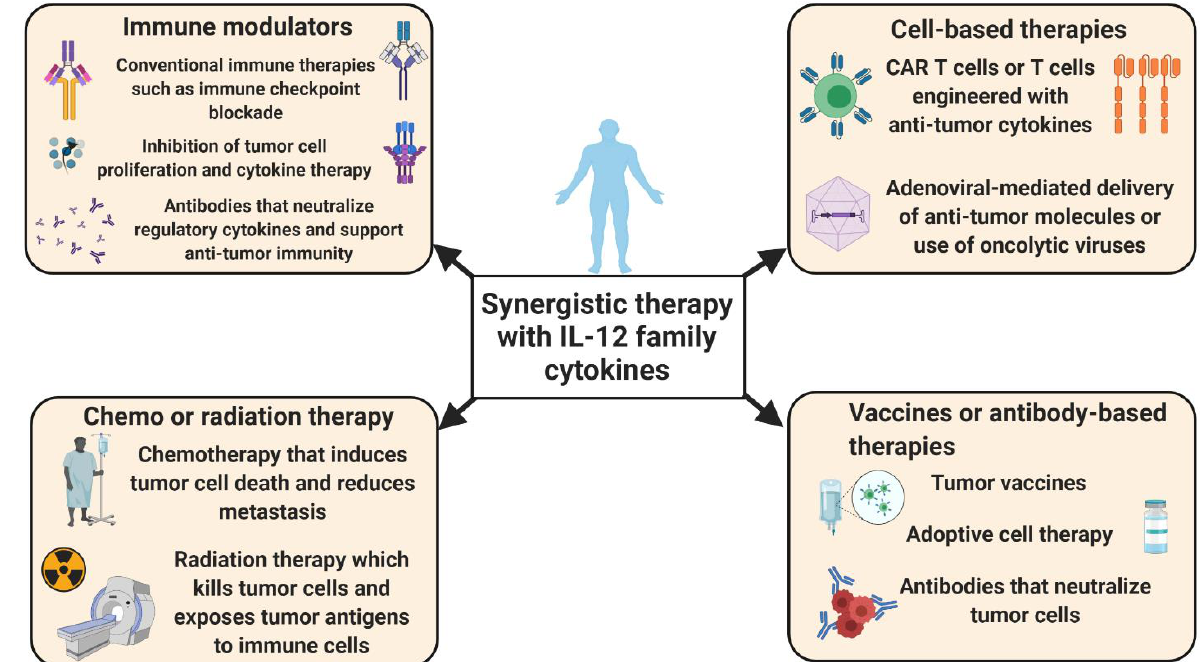
Figure 2. The therapeutic modulation of IL-12 family cytokines may enhance the efficacy of conventional therapy. Recent studies indicate that the therapies targeting (either upregulating or downregulating) the IL-12 family cytokines in combination with other standard therapies may increase treatment effectiveness. Context-dependent functions of IL-12 cytokines in cancer could drive the development of inhibitor or augmentative therapy axes, respectively. Drugs or antibodies targeting IL-12 family cytokines may help to restrain immune suppression within the tumor microenvironment (TME) and allow for the infiltration and proliferation of anti-tumor immune cells. Additionally, the targeted delivery of these cytokines with the help of adenovirus or chimeric antigen receptor (CAR) T cells may enhance cytotoxicity and tumor cell clearance. Such approaches could make tumor cells more sensitive to radiation, chemotherapy and immune checkpoint blockade therapy.